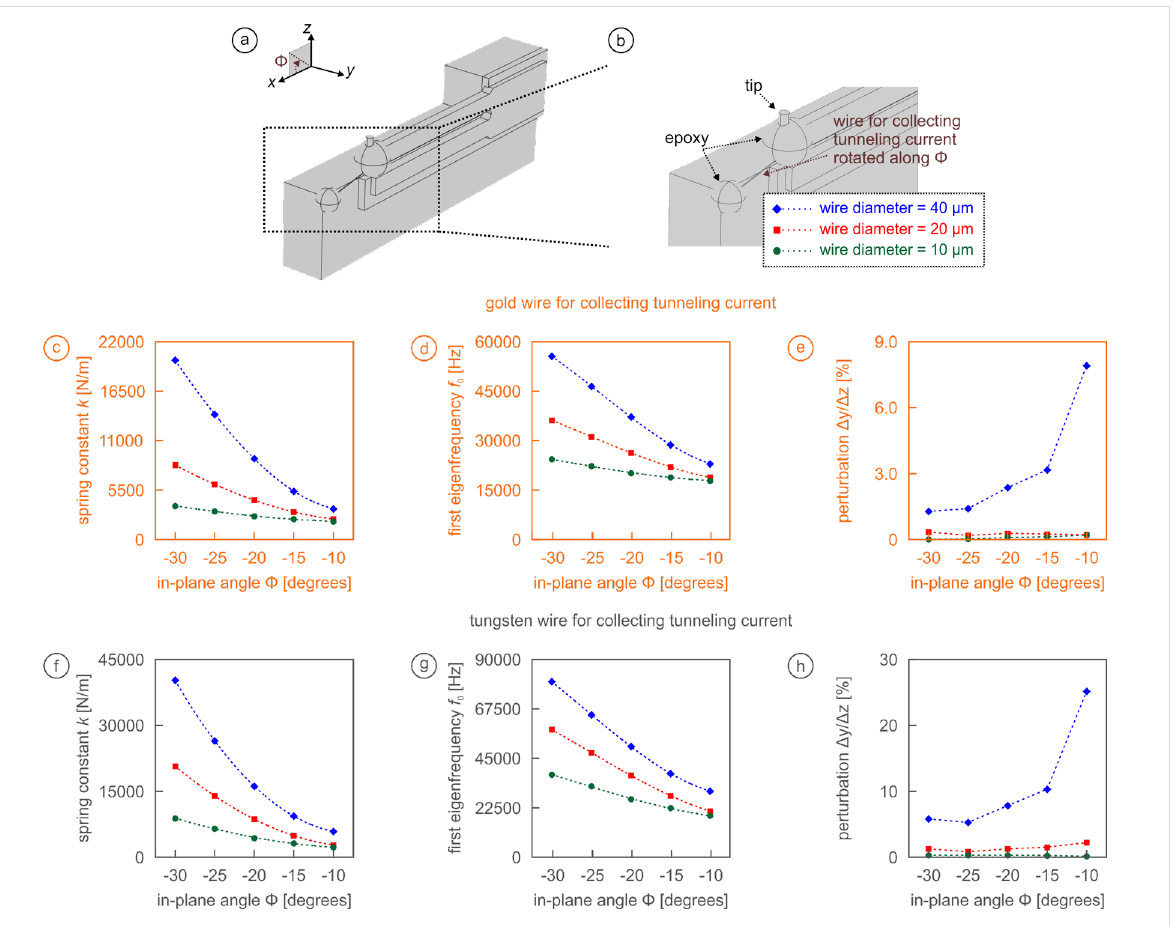
Figure 5: Effect of material choice (gold or tungsten), wire diameter (10 µm, 20 µm, or 40 µm), and in-plane angle on spring constant k , eigenfre- quency f 0 , and perturbation ∆ y / ∆ z of the sensor. (a,b) Perspective view of the model geometry and definition of the in-plane angle . (c–h) Results from finite element modeling for gold (c–e) and tungsten (f–h) wires with three different diameters: 10 μ m (green circles); 20 μ m (red squares); and 40 μ m (blue diamonds). For certain parameter sets, large increases from the values without wire are detected for k and f 0 , while the perturbation Δ y / Δ z remains acceptably small except for the thickest wire